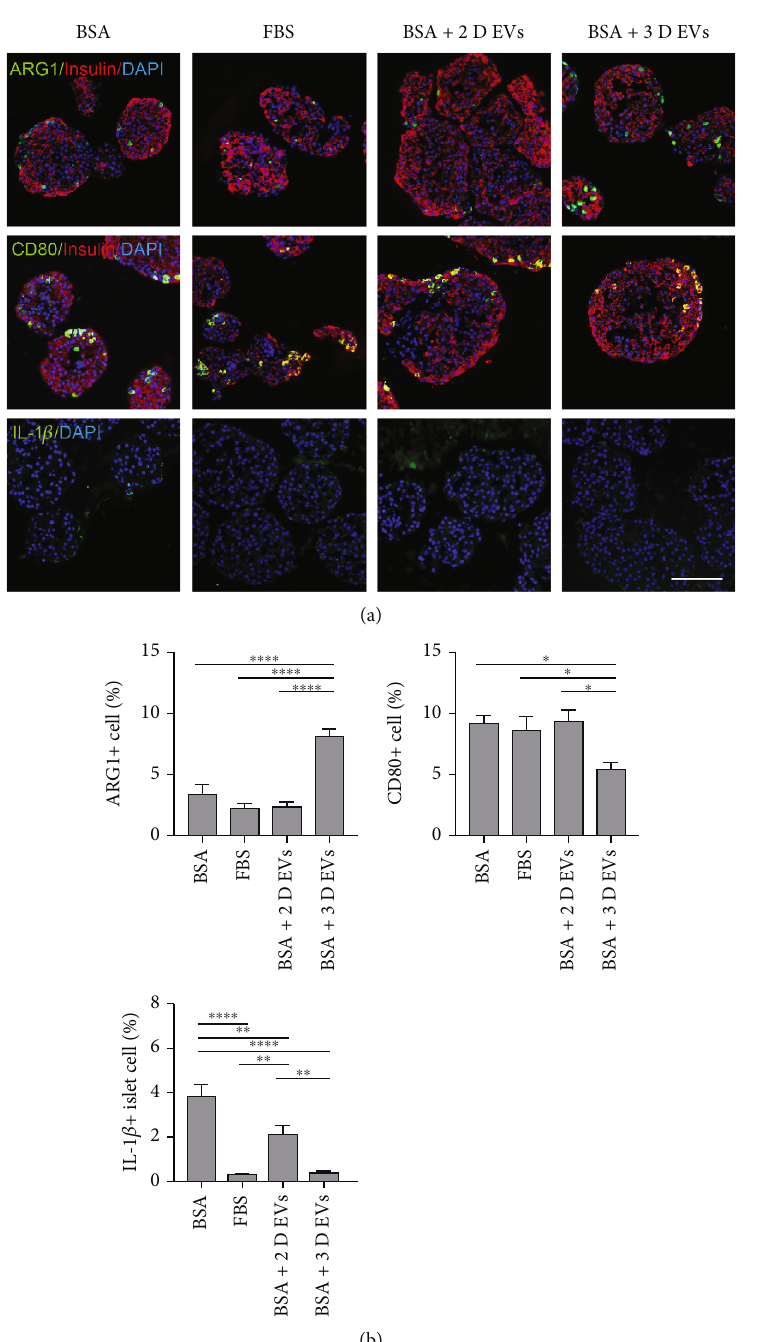
Figure 6: E ff ect of 3D hUCB-MSC-derived EVs on M1/M2 polarization of islet-resident macrophages in islets. The hIAPP +/- mouse islets were cultured under four conditions: medium supplemented with 10% fetal bovine serum (FBS group), medium supplemented with 0.625% bovine serum albumin (BSA group), 20 μ g/mL 2D hUCB-MSC-derived EVs plus 0.625% BSA (BSA+2D EV group), and 20 μ g/mL 3D hUCB-MSC-derived EVs plus 0.625% BSA (BSA+3D EV group). (a) Immunocytochemical staining with antibodies against insulin (red), DAPI (blue), and ARG1, CD80 and IL-1 β (green). Scale bar = 100 μ m . (b) The percentage proportions of ARG1-, CD80-, and IL-1 β - stained cells (green) among total DAPI-positive islet cells (blue; 50 ~ 100 islets per group). The error bars represent the standard deviation of measurements in three separate sample runs ( n = 12 ). Columns, mean; bars, SD. ∗ p < 0 : 05 , ∗∗ p < 0 : 005 , ∗∗∗ p < 0 : 0005 , and ∗∗∗∗ p < 0 : 0001 by one-way ANOVA and Tukey ’ s